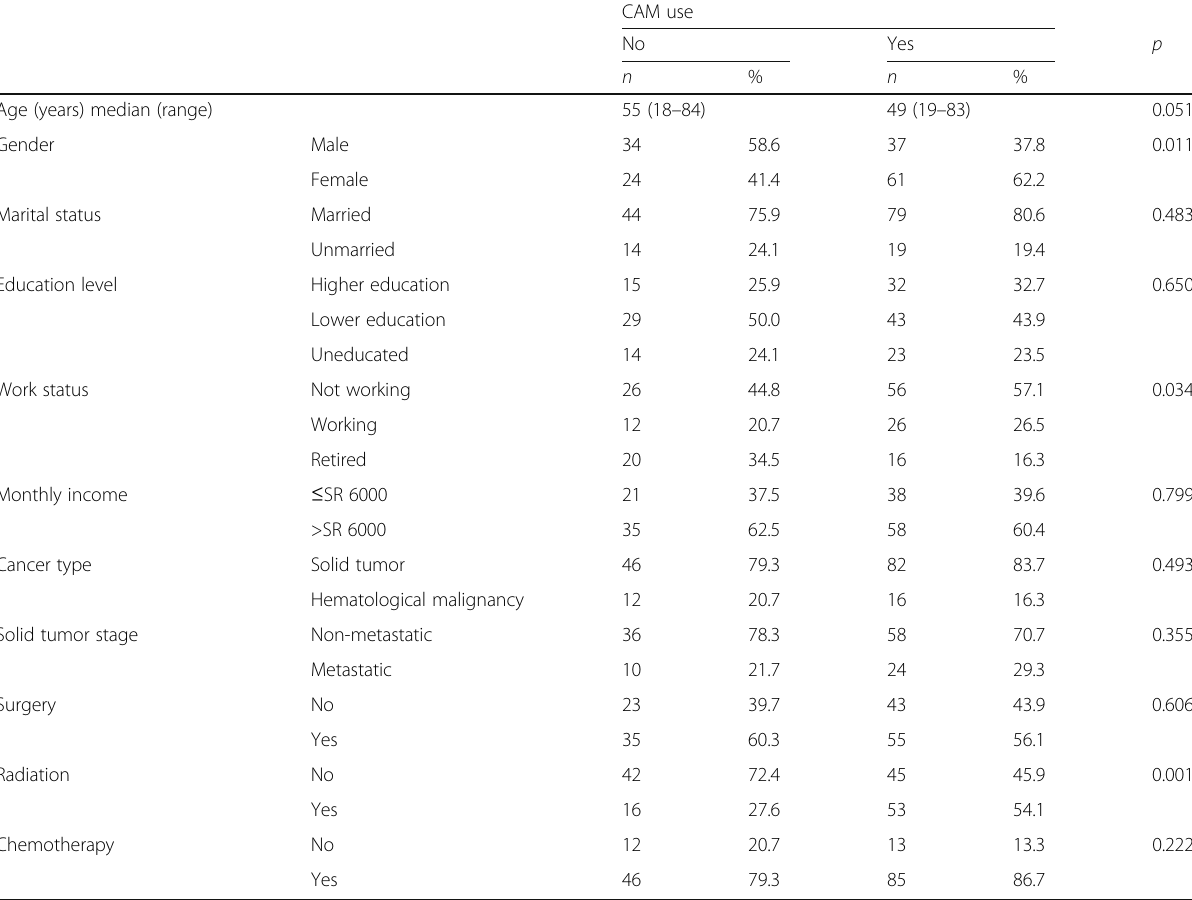
Table 3 Univariate analysis of the association between complementary and alternative medicine (CAM) use and demographic and clinical factors